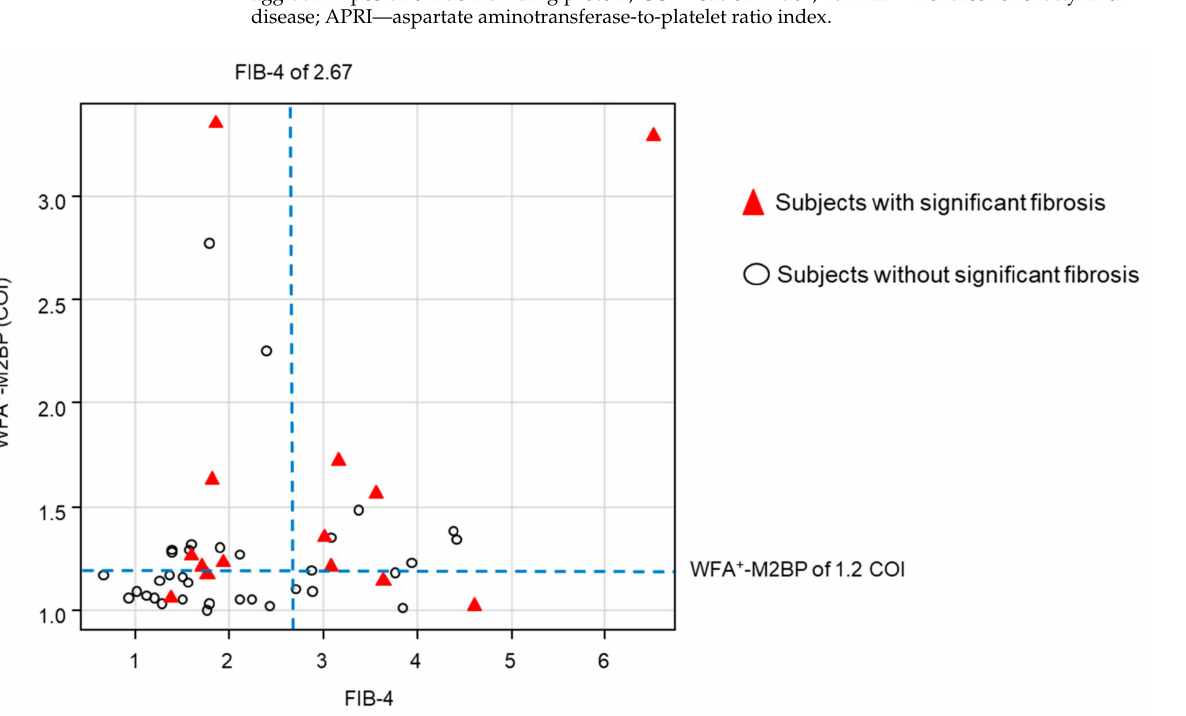
Figure 4. Association between WFA + -M2BP, FIB-4, and subjects with significant fibrosis. The blue dotted lines show the threshold of WFA + -M2BP and FIB-4. The red triangles show the subjects with significant fibrosis. The white circles show the subjects without significant